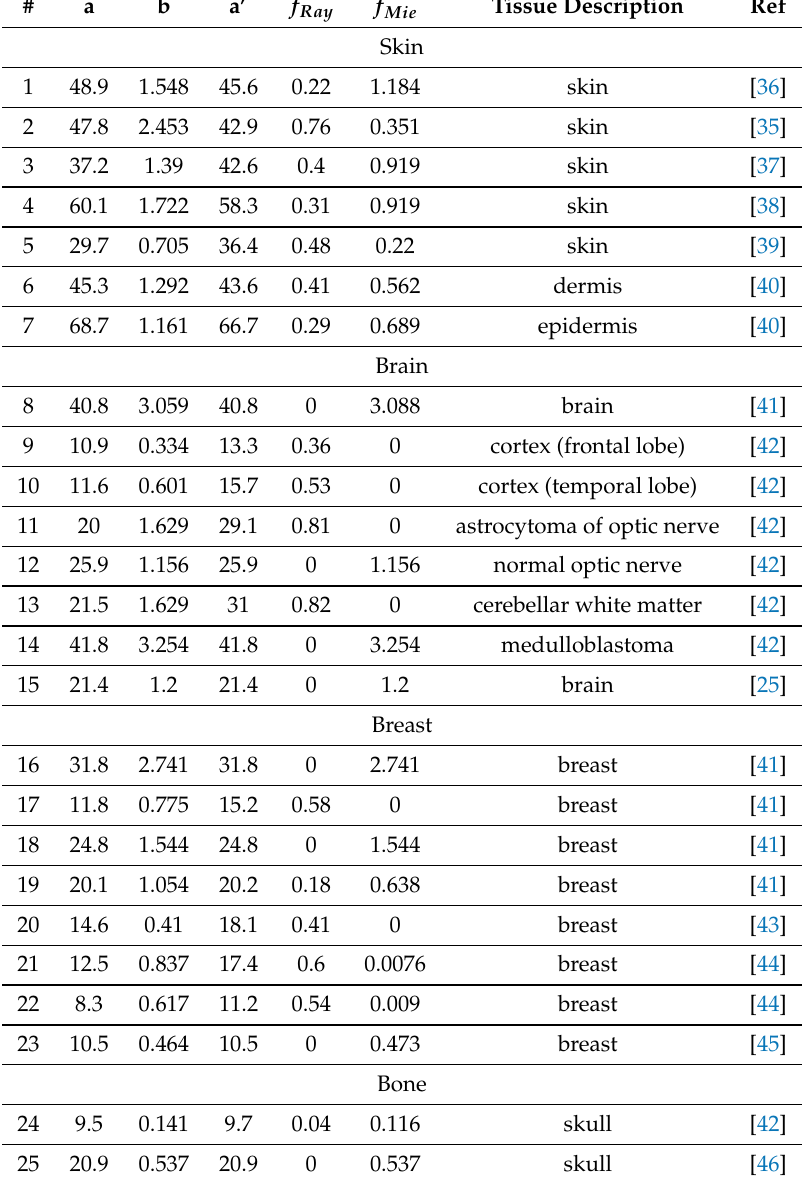
Table 1. Represents the different tissues (e.g., skin, brain, breast, bone) description using scattering parameters, where a is the µ s (cid:48) value at the reference wavelength and b is the characteristic power dependence and f Ray or f Mie demonstrated the fraction of small and large scatterers,